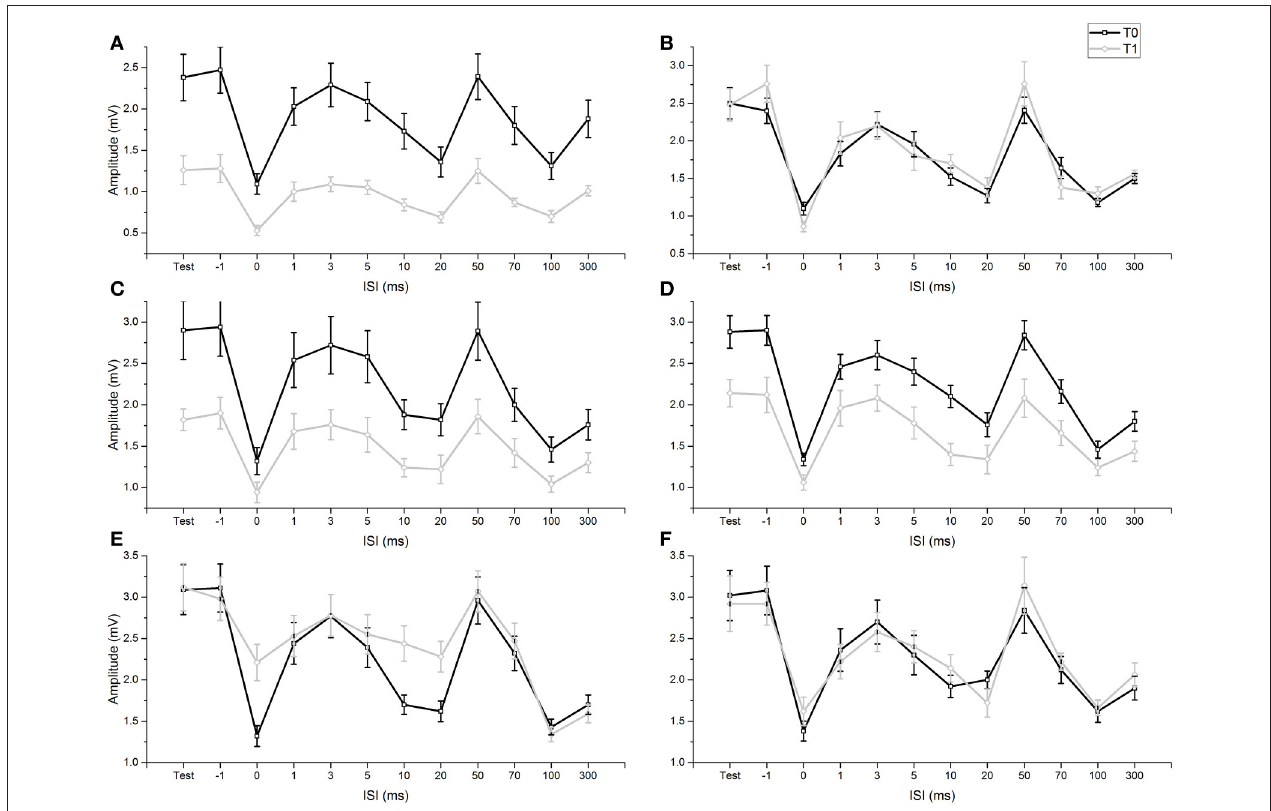
FIGURE 2 | Comparison of conditioned and unconditioned HR amplitude before (T0) and after (T1) fMV. FMV delivered over FCR (A) , BB (C) and APB (D) induced a decrease in the amplitude of unconditioned (test) and conditioned HR at all ISI (all p -values < 0.01). By contrast fMV applied over the ECR (E) muscle significantly decreased conditioned HR amplitude only at ISI of 0, 10, and 20ms (all p -values < 0.01), while leaving unconditioned HR unchanged. Voluntary contraction alone of FCR (B) and ECR (F) had no effect. Error bars indicate standard error.